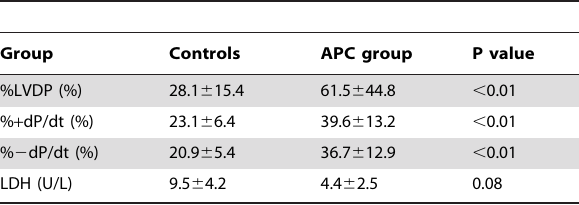
Table 1. Assessment of cardiac performance in the global ischemia/reperfusion (I/R) injury model.